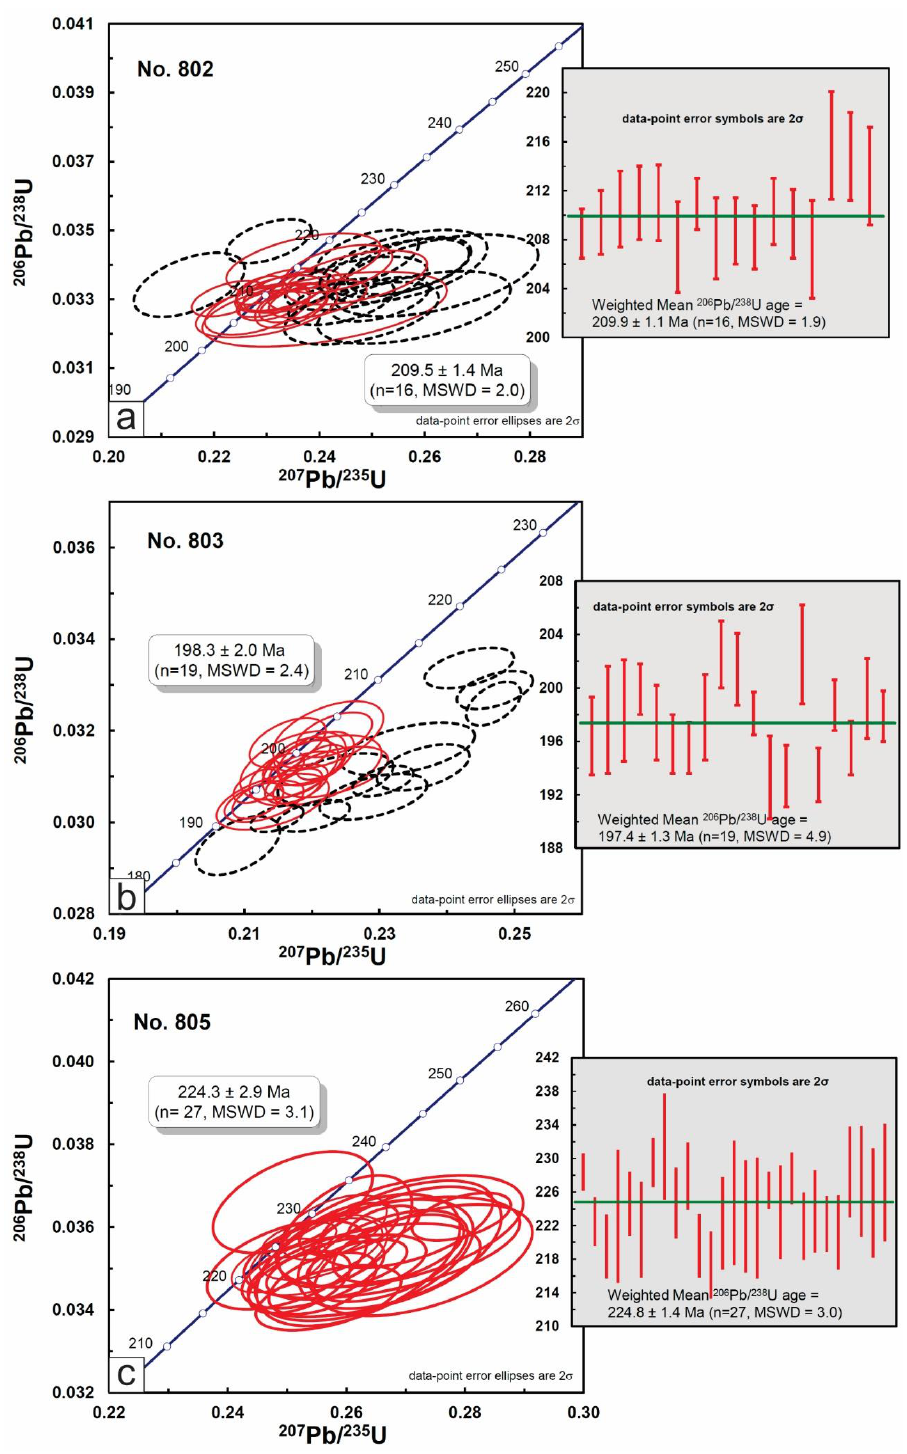
Figure 8. U-Pb concordia diagram for CGMs from the Li-rich pegmatites at Kalu’an. ( a ) diagram showing a Concordia age of 209.5 ± 1.4 Ma for No. 802 pegmatite. ( b ) nineteen datapoints on the Concordia yielding 198.3 ± 2.0 Ma for No. 803 pegmatite. ( c ) diagram showing a Concordia age of 224.3 ± 2.9 Ma for No. 805